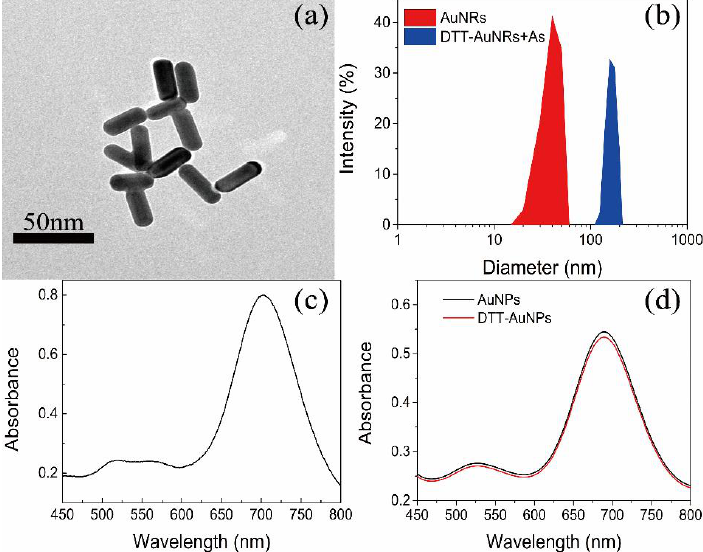
Figure 2. ( a ) TEM image of AuNRs; ( b ) Size distribution of AuNRs and DTT-AuNRs exposed to As(III); ( c ) UV–vis absorption spectra of CTAB-coating AuNRs; ( d ) UV–vis absorption spectra of AuNRs and DTT-AuNRs.